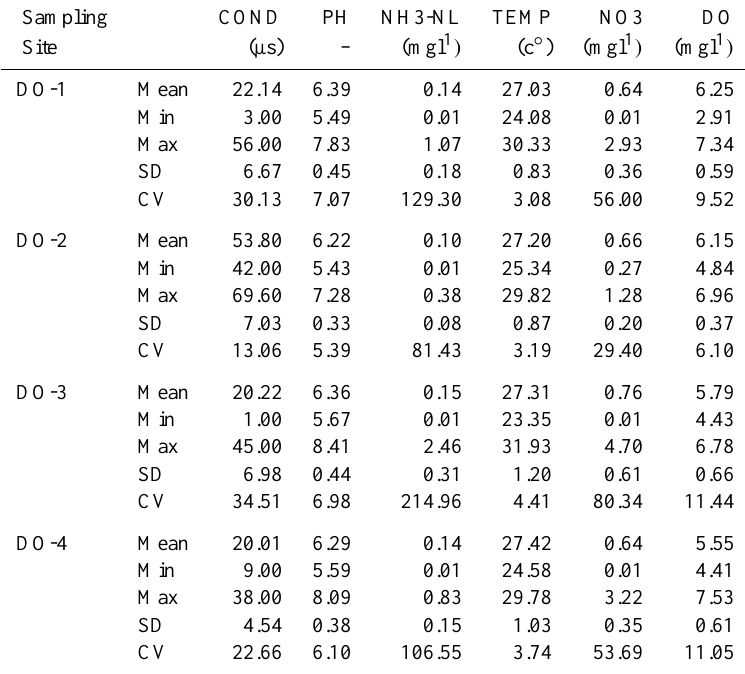
Table 2. Basic statistics of the measured water quality parameters in Johor River.